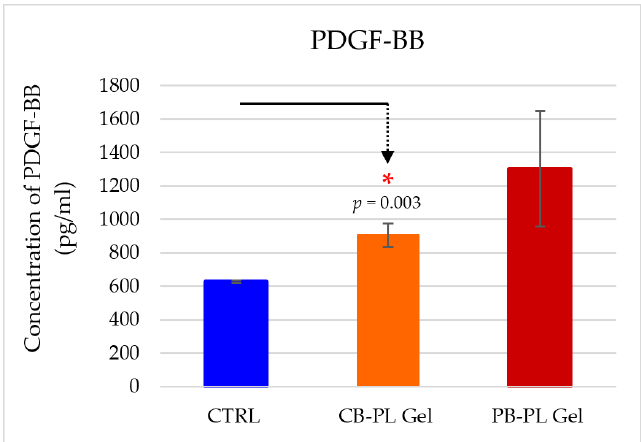
Figure 6. PDGF-BB released from gels of CB-PL and PB-PL and CTRL on day 3 of wound healing. The results were based on six independent tests ( n = 6) and the means ± SEM were provided. The statistical significance of CB -PL gel compared to CTRL on day 3 was indicated by * p < 0.05.